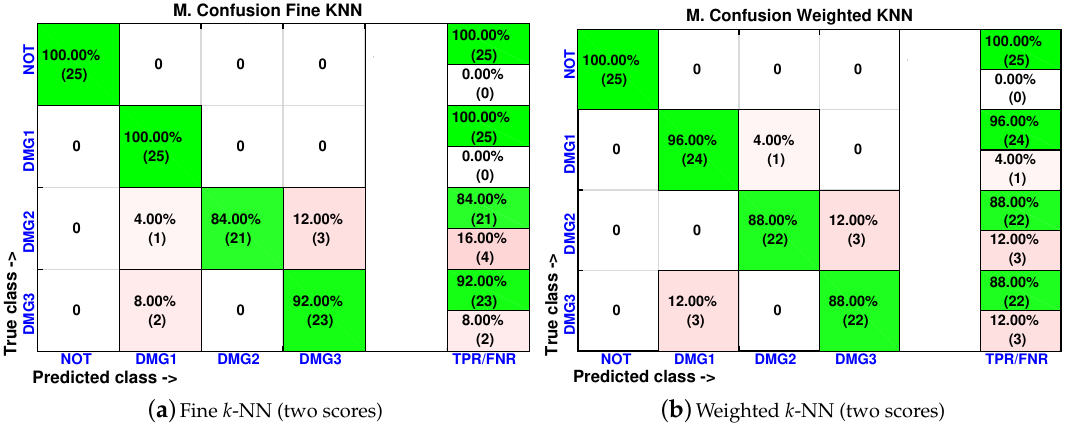
Figure 26. Confusion matrix using fine k -NN ( a ) and weighted k -NN ( b ) when the feature vector is formed by the first two principal components.